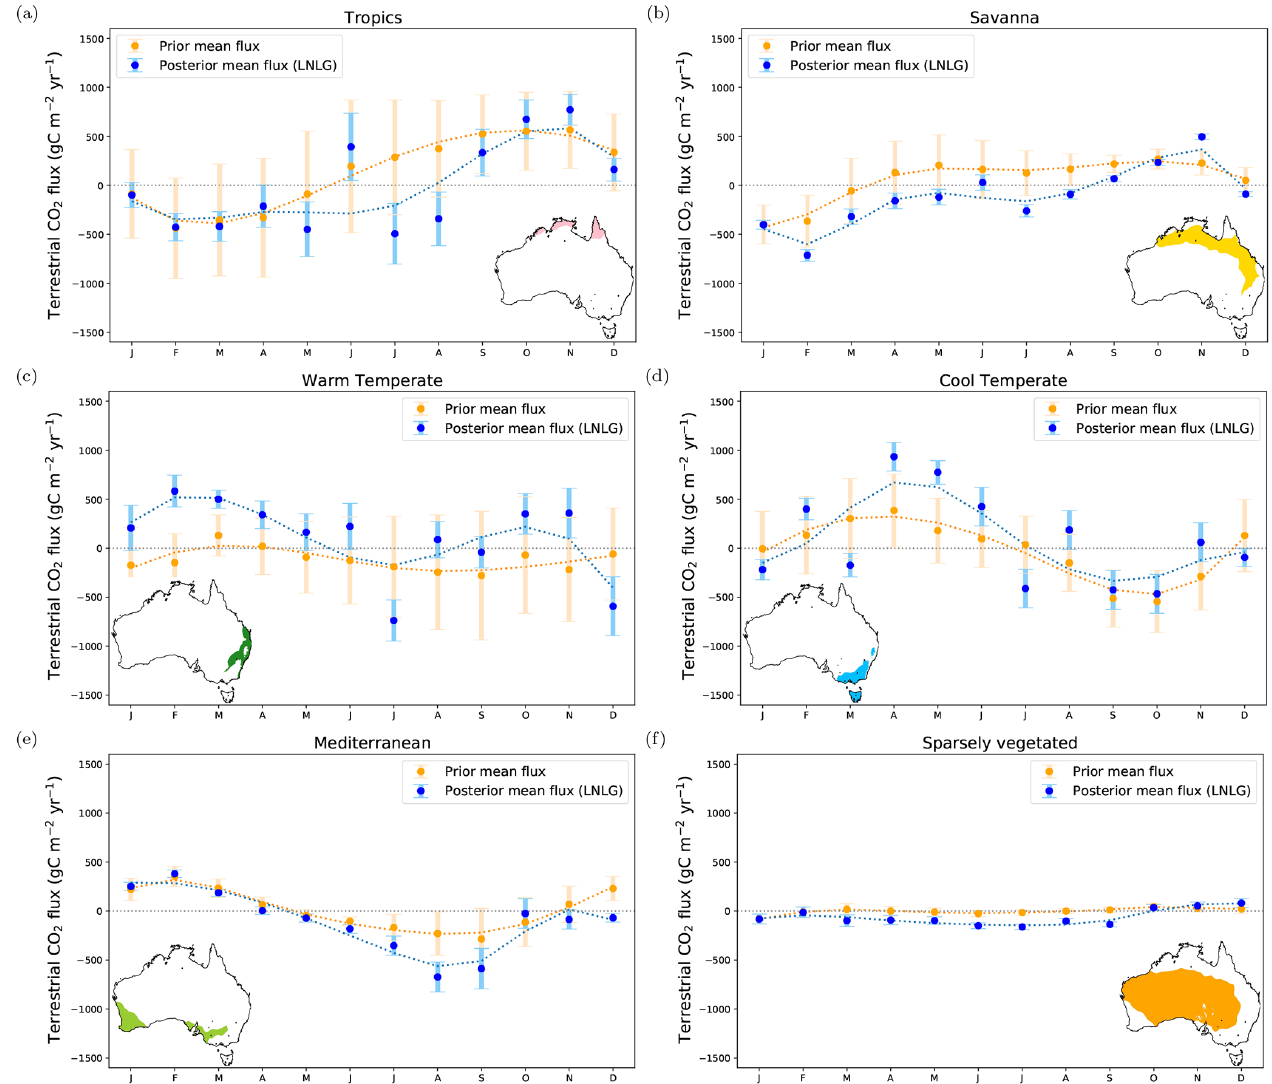
Figure B1. Monthly time series of the Australian land biosphere prior and posterior CO 2 flux and their uncertainties in gCm − 2 yr − 1 over six bioclimatic regions. The prior and posterior estimates do not include fossil fuel